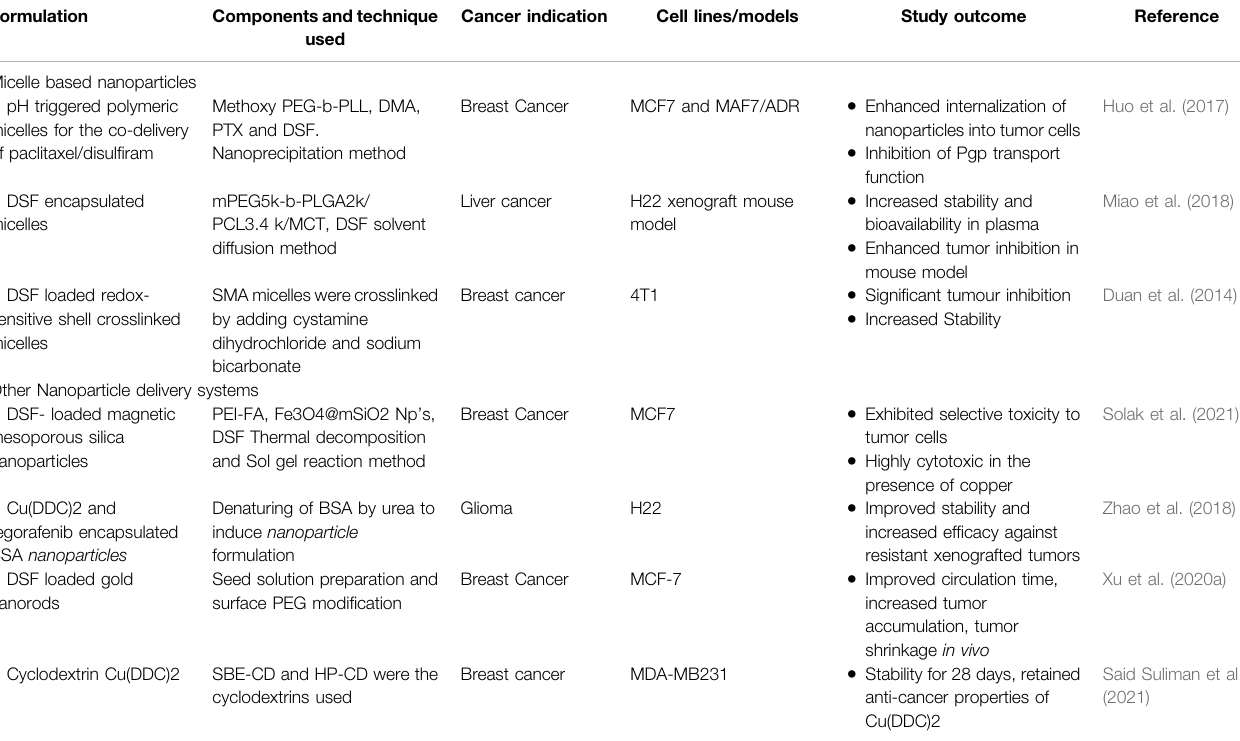
TABLE 3 | ( Continued ) Formulation strategies used for delivery of disul fi ram for cancer